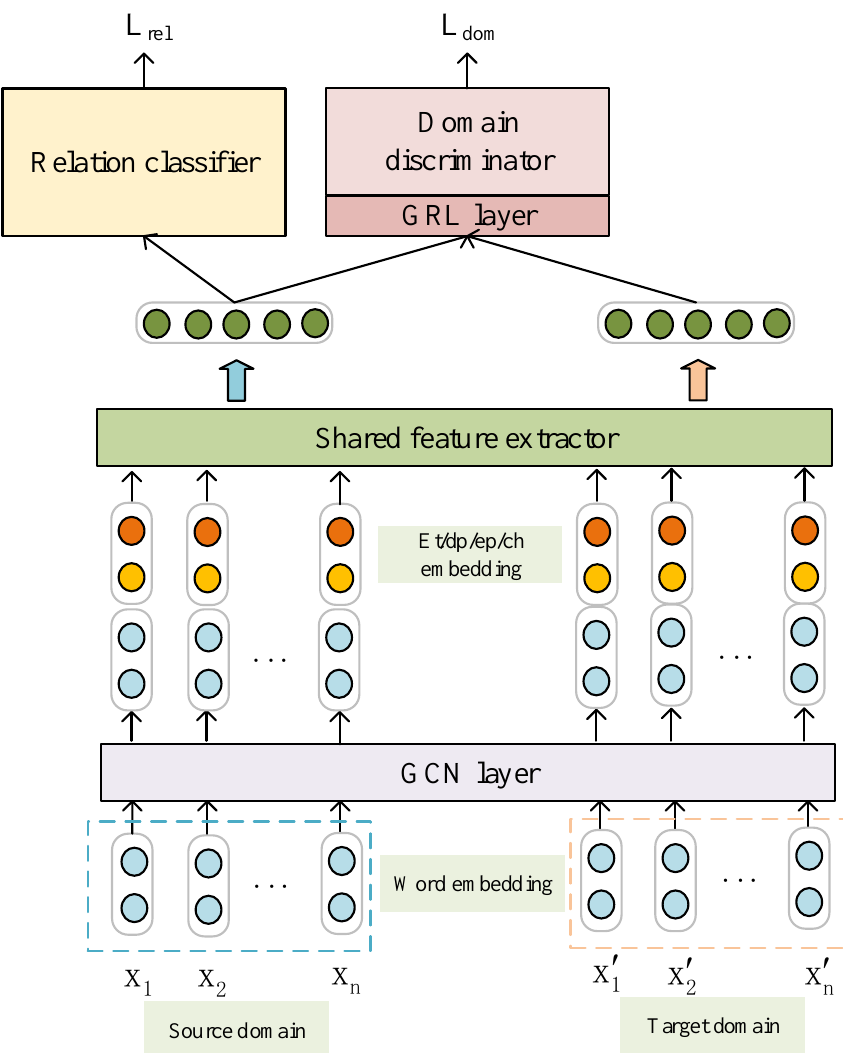
Figure 2. The overall architecture of our graph adaptation